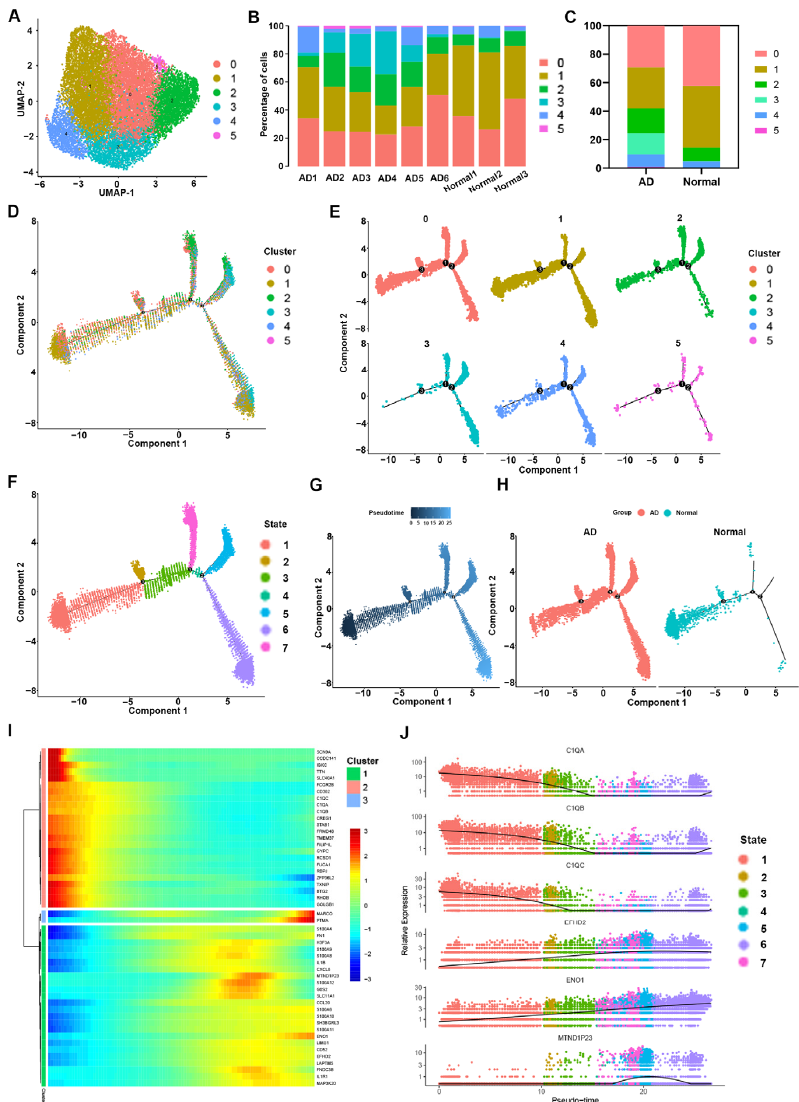
Figure 2. The heterogeneity of macrophages found in AD vs. normal aorta tissue. ( A ) UMAP plot of macrophages reclustered into six subclusters. ( B ) Bar plots of the proportion of macrophage subclusters in nine aortic samples. ( C ) Bar plots of the proportion of macrophage subclusters in the AD and normal groups. ( D ) The Monocle pseudotime trajectory plot shows the progression of six macrophage subclusters. ( E ) Monocle pseudotime trajectory plots of each macrophage subcluster. ( F ) The macrophage subcluster trajectory was separated into seven cell states. ( G ) Monocle pseudotime trajectory plot of macrophages presenting the beginning and end pseudotime profiles. ( H ) The macrophages trajectories in the AD and normal groups. ( I ) The heatmap shows the expression levels of genes grouped into three gene modules according to the pseudotime axis. ( J ) Pseudotime kinetics of the top six genes among the six macrophage subclusters. Each dot represents a cell, different colors represent different clusters, and the ordinate represents the expression level of each